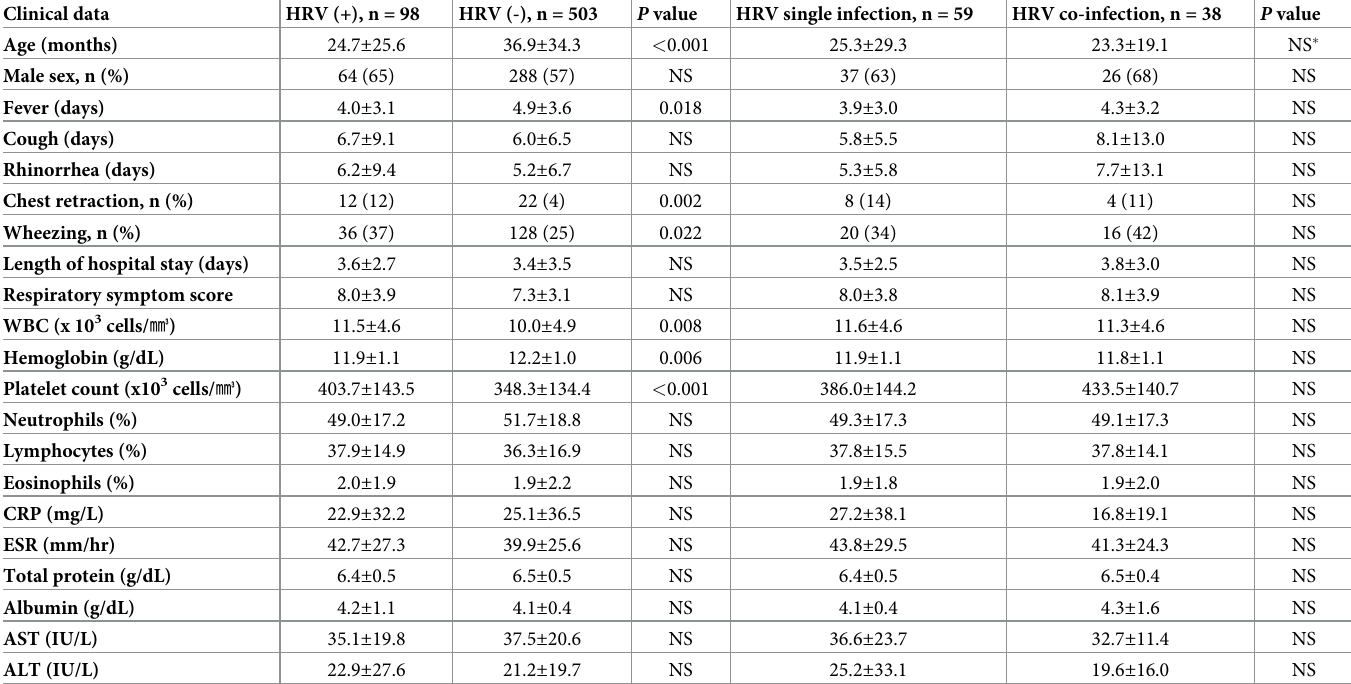
Table 1. Demographic, clinical and laboratory characteristics of HRV-positive, -negative, single-, and co-infected patients. Clinical